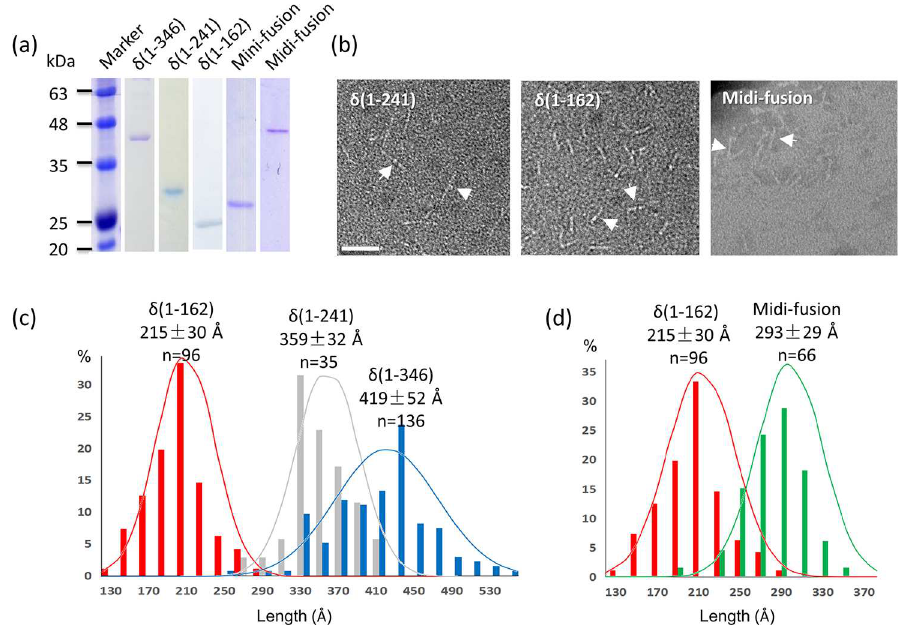
Fig 2. Truncation mutants of δ and CP- δ . (a) SDS-PAGE showingfive purifiedproteins. (b) Negative- stainingEM images. δ (1–241), δ (1–162)and the midi-fusion all formed fiber-shaped molecules.Some of these fibers are highlightedby arrows. Scale bar, 500 Å . (c) Length measurements for the two δ truncation mutants in comparison with the full-length δ . (d) Lengthmeasurements for the midi-fusionproteinin comparisonwith δ